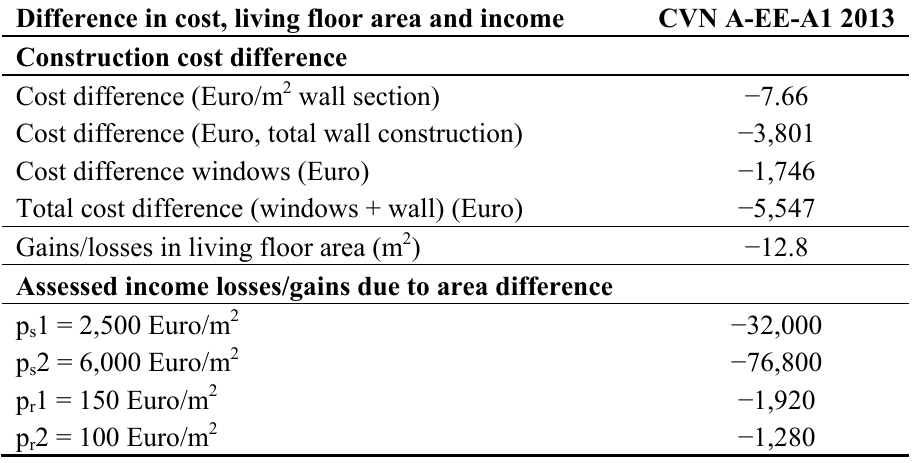
Table 7. Cost difference and assessed living area lost between conventional and energy-efficient building constructed in 2013, timber